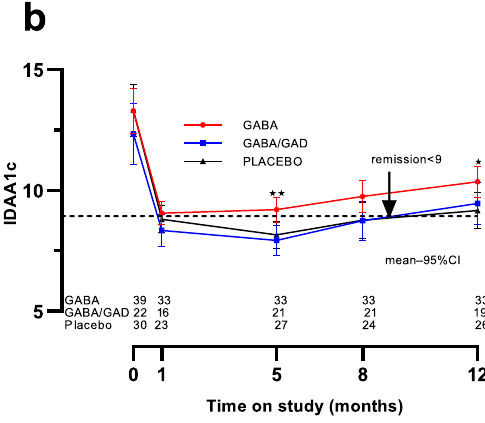
Fig. 3 | Glycemic control in study groups over time. Glycosylated Hemoglobin (HbA 1c )( a )andinsulinadjustedA1c( IDAA1c )( b )weremeasuredinthethreestudy groups. Results are shown as mean±95% CI and statistical comparisons were by two-sided analysis of covariance. Regarding HbA1c ( a ) at 5-months GABA vrs.